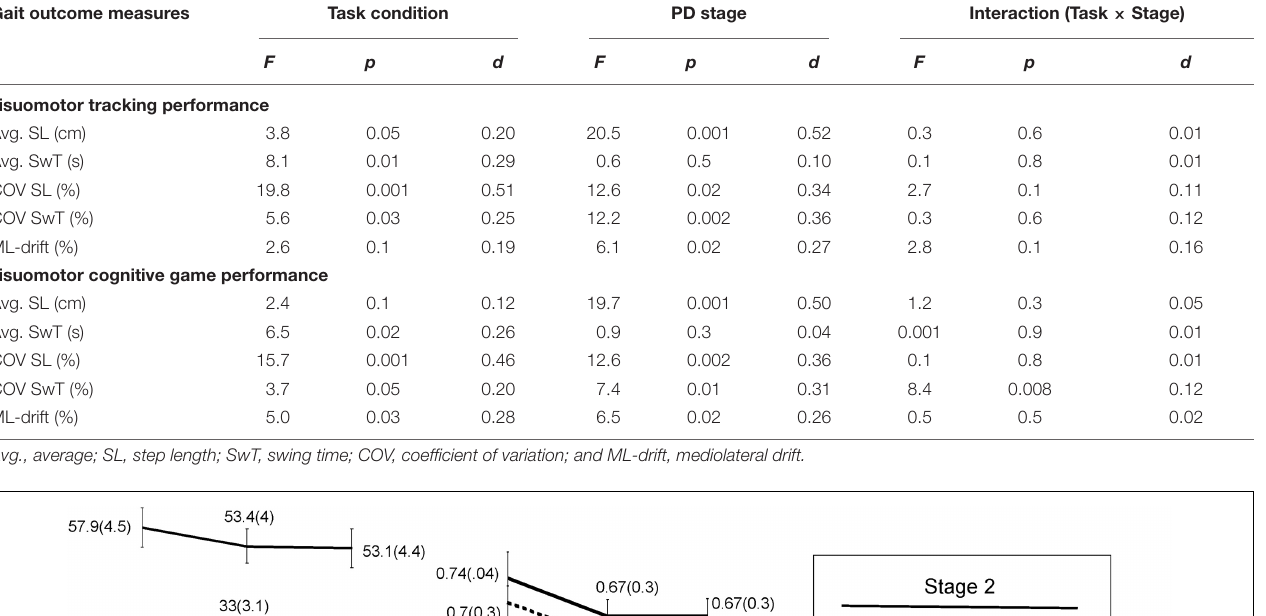
TABLE 4 | Main effects and effect sizes (Cohen’s d ) of task condition and PD severity on the gait outcome measures. Gait outcome measures Task condition PD stage